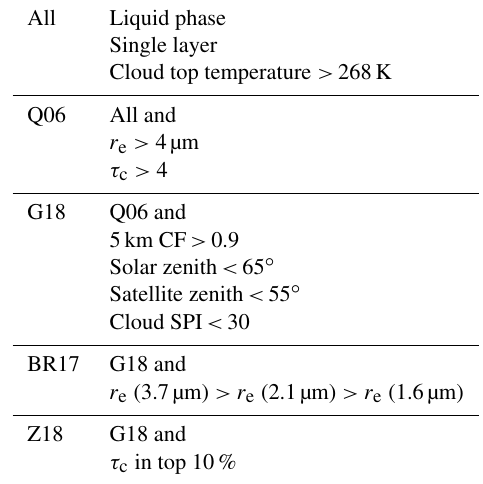
Table 1. Summary of sampling